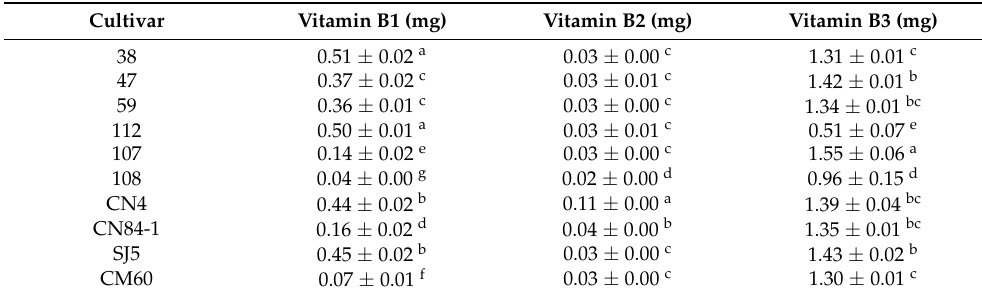
Table 3. Vitamin contents of ten bean cultivars (per 100 g dry